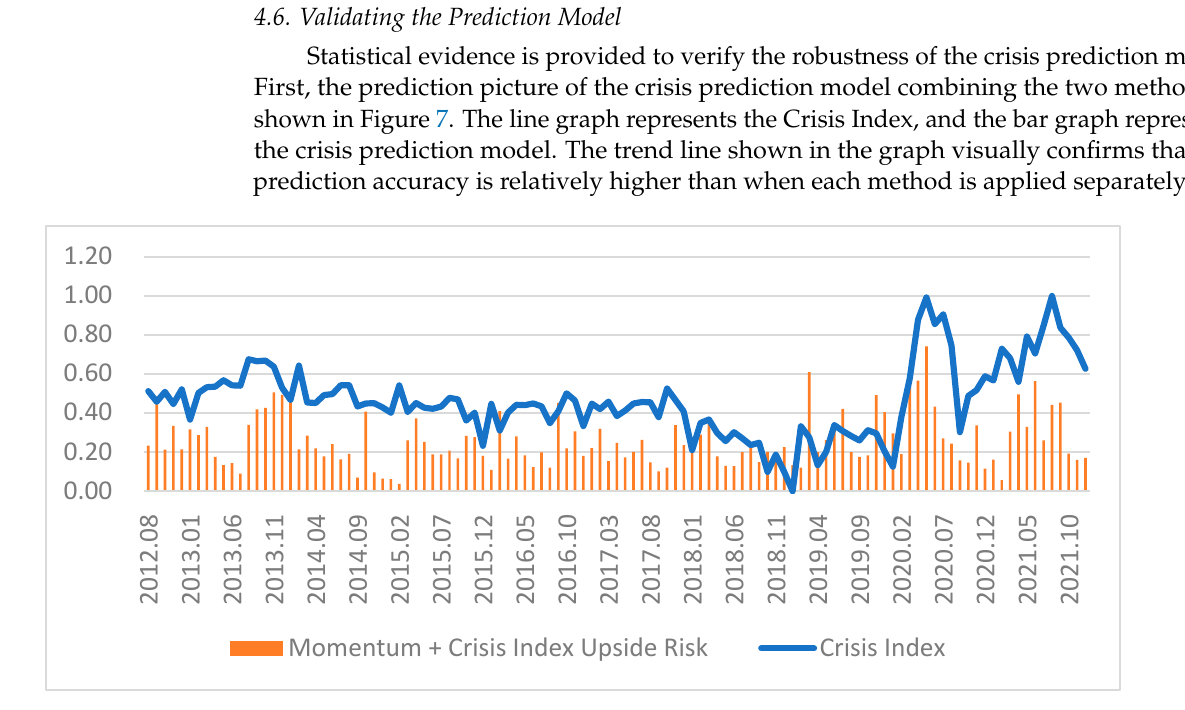
Table 3. Correlation of Crisis Prediction Model Variables.